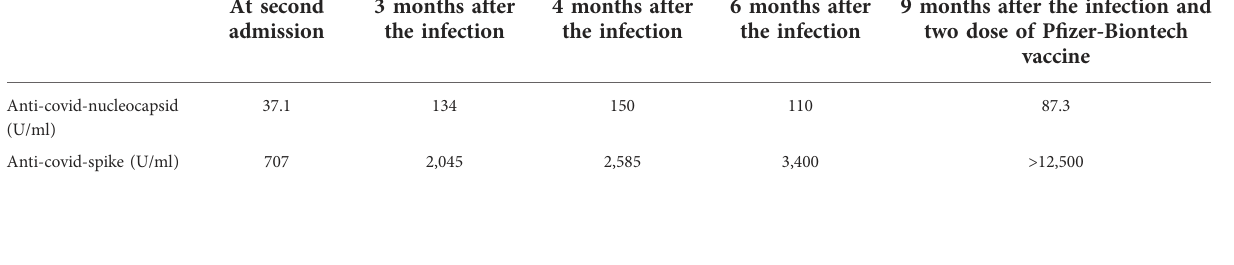
TABLE 2 COVID-19 antibody titres of the